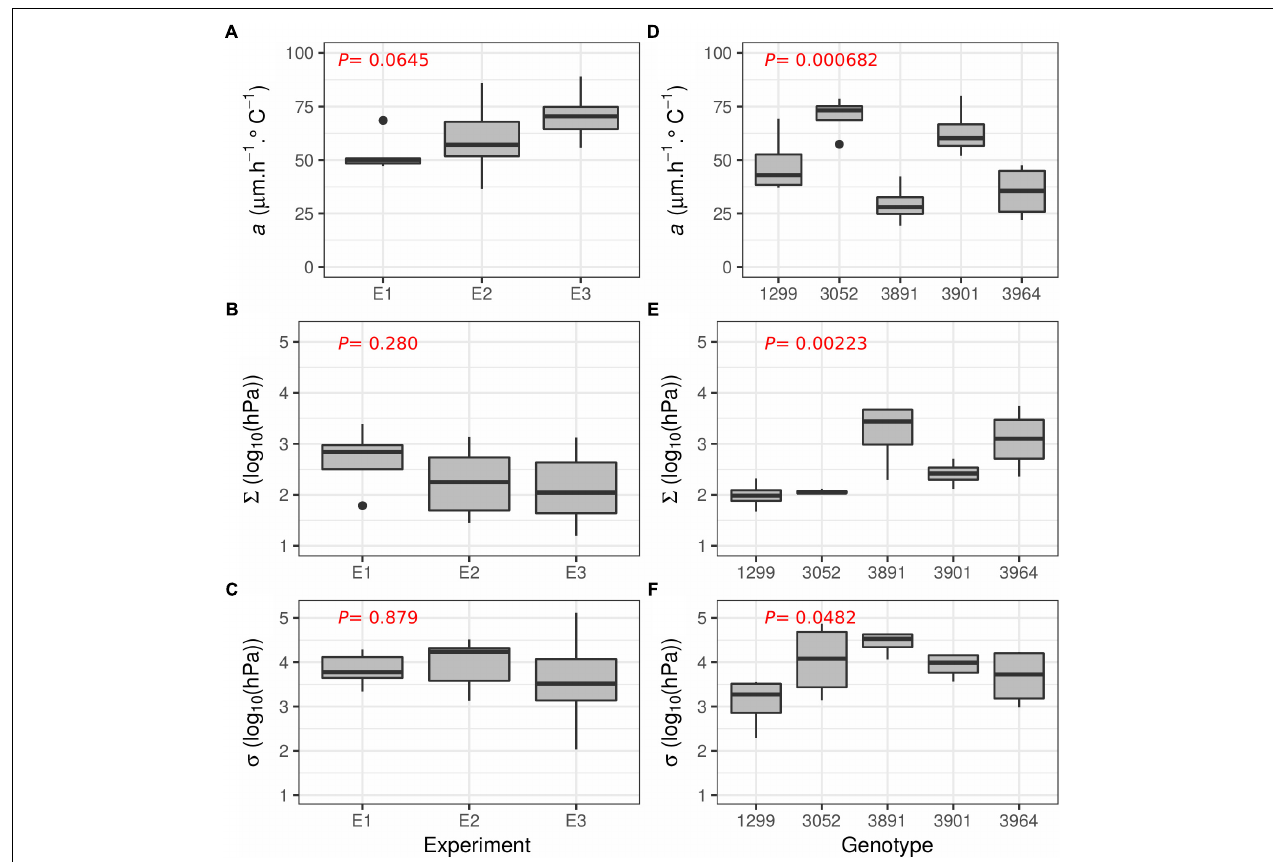
FIGURE 5 | Boxplots illustrating the reproducibility of the phenotyping method and the Tri-Phase function across different experiments and genotypic responses. (A–C) Shows the results from the three replicated experiments (E1, E2, and E3) using the genotype “Arara B” with 7, 10, and 10 replicates per experiment, respectively. (D–F) Shows the response of the five different perennial ryegrass genotypes 1299, 3052, 3891, 3901 and 3964, each evaluated with four replicates. (A,D) Shows the LER per degree ( a , µ m h − 1 ◦ C − 1 ), (B,E) the estimates when leaf elongation slows [ (cid:54) , log 10 (hPa)], and (C,F) when leaf growth arrests [ σ , log 10 (hPa)]. P -values from a one way ANOVA are given in red at the top left of each